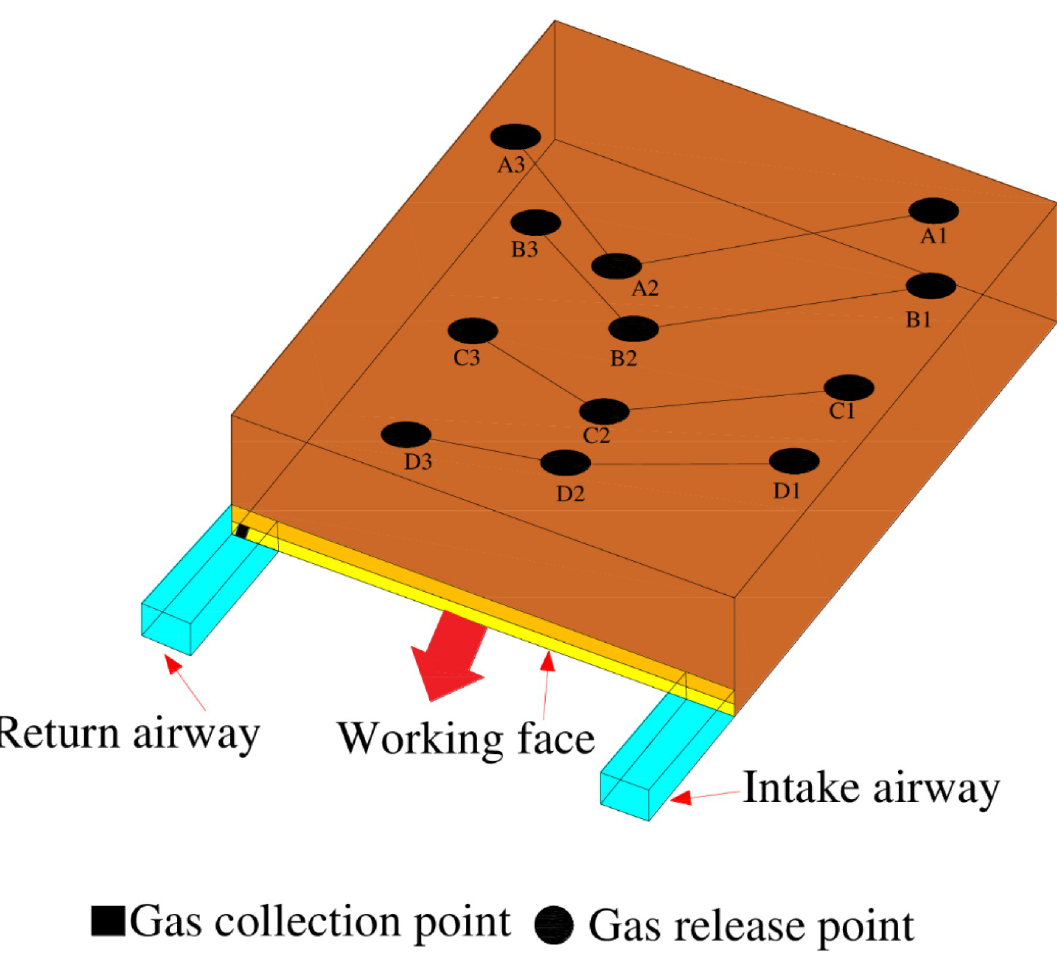
Fig 2. Layout of the SF 6 release points and collection